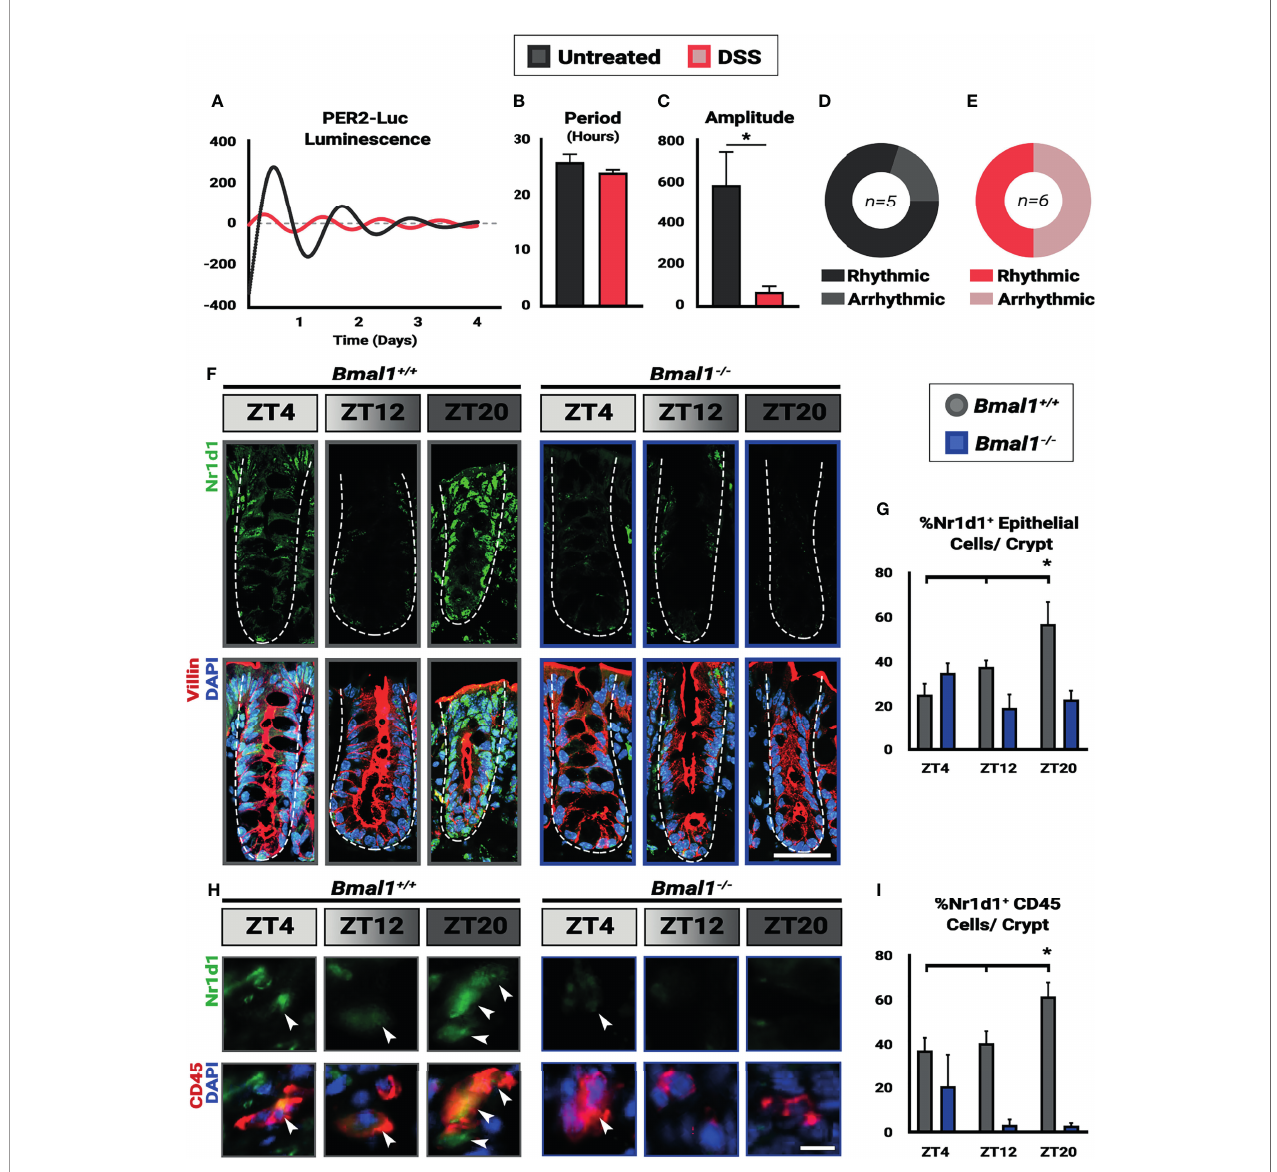
FIGURE 2 | Colitisdampenscircadian rhythms inthe colon.Micewere treated with 4% DSS and collected at Zeitgeber times (ZT)4, 12, and 20. (A) Colon explants show dampened circadian rhythms in Per2::Luc animalstreated with DSS. (B) Despitethe lower amplitudeofthe rhythms inDSS-treated mice, nodifferencein periodispresent in the colon tissue (Unpaired t -test, p=0.3131). (C) Amplitude in Per2::Luc rhythms isdecreased inDSS-treated explants (Unpaired t -test, *p=0.0410). (D) 80% of untreated explants exhibit high-amplitude rhythms. (E) 50% of DSS treatedexplants exhibitlow amplitude rhythms, andthe rest are arrhythmic. (F) Nr1d1 protein (in green)is expressed in Bmal1 +/+ control Villin + epithelial cells (in red)(Scalebar = 50µm. Dashed lines indicate cryptoutline). (G) The peak inNr1d1 expression in Villin + epithelial cells occursat ZT20, andNr1d1proteinis present at decreasedlevelsin Bmal1 -/- mutant tissue ( Bmal1 +/+ One-way ANOVA, *p=0.0383, F=5.898; Tukey ’ s test, ZT20 *p=0.0134). (H) Nr1d1 protein (in green) isexpressed in Bmal1 +/+ control colon lamina propriaCD45+ blood cells (in red) (Arrowheads indicate examples of CD45 + cells. Scale bar = 10µm). (I) The peak inNr1d1expression in CD45+ cells also occurs at ZT20, andNr1d1protein ispresent at decreased levels in Bmal1 -/- mutants ( Bmal1 +/+ One-way ANOVA, *p=0.0483. F=5.238; Tukey ’ s test, ZT12 *p=0.0391, ZT20 *p=0.0011).(Allerrorbarsrepresent